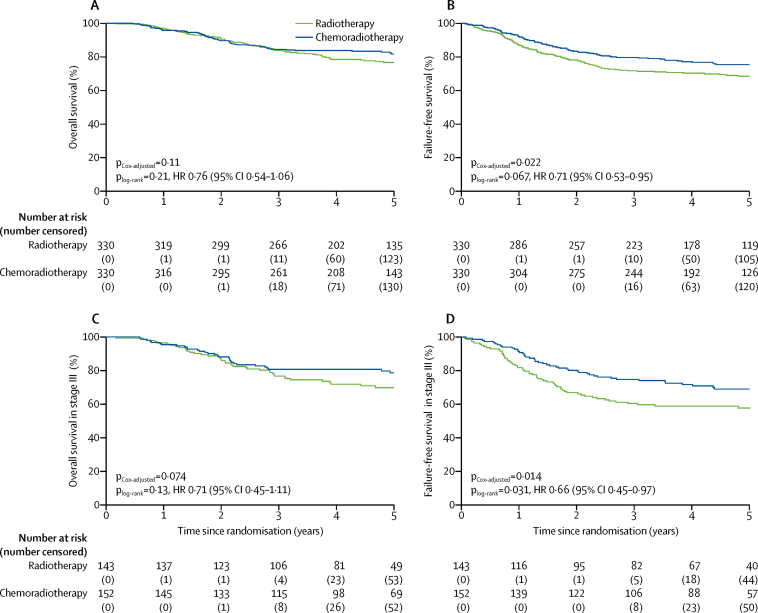
Overall survival and failure-free survivalKaplan-Meier survival curves for overall survival (A) and failure-free survival (B) in all patients, and for overall survival (C) and failure-free survival (D) of patients with stage III endometrial cancer. Plog-rank=unadjusted log-rank p value. PCox adjusted=p value adjusted for stratification factors. HR=hazard ratio.